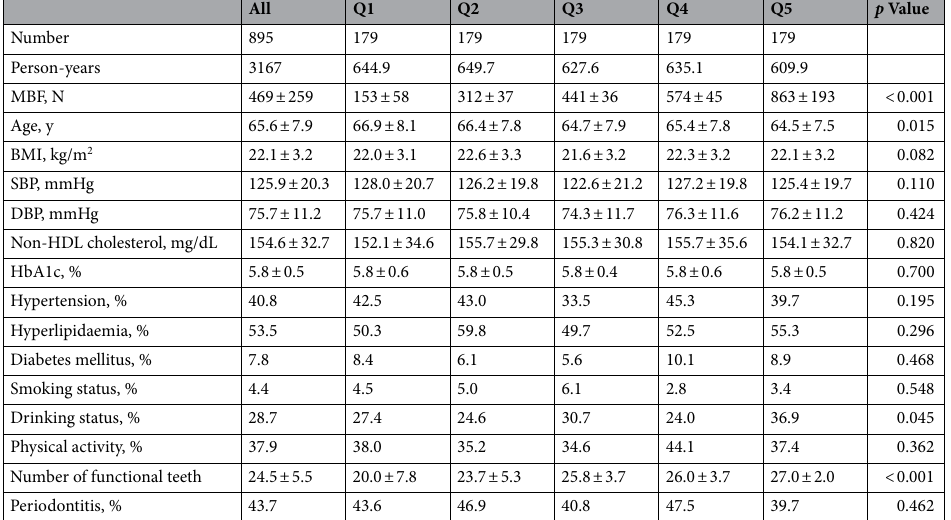
Table 3. Subjects’ baseline characteristics by MBF quintiles in women. Data are frequencies or means ± SD. MBF, maximum bite force; BMI, body mass index; SBP, systolic pressure; DBP, diastolic blood pressure; HDL, high-density lipoprotein-cholesterol; Physical activity, ≥ 60 min walking per day. Analysis of variance was used for comparisons of multiple group means, and the Chi-squared test was used to compare